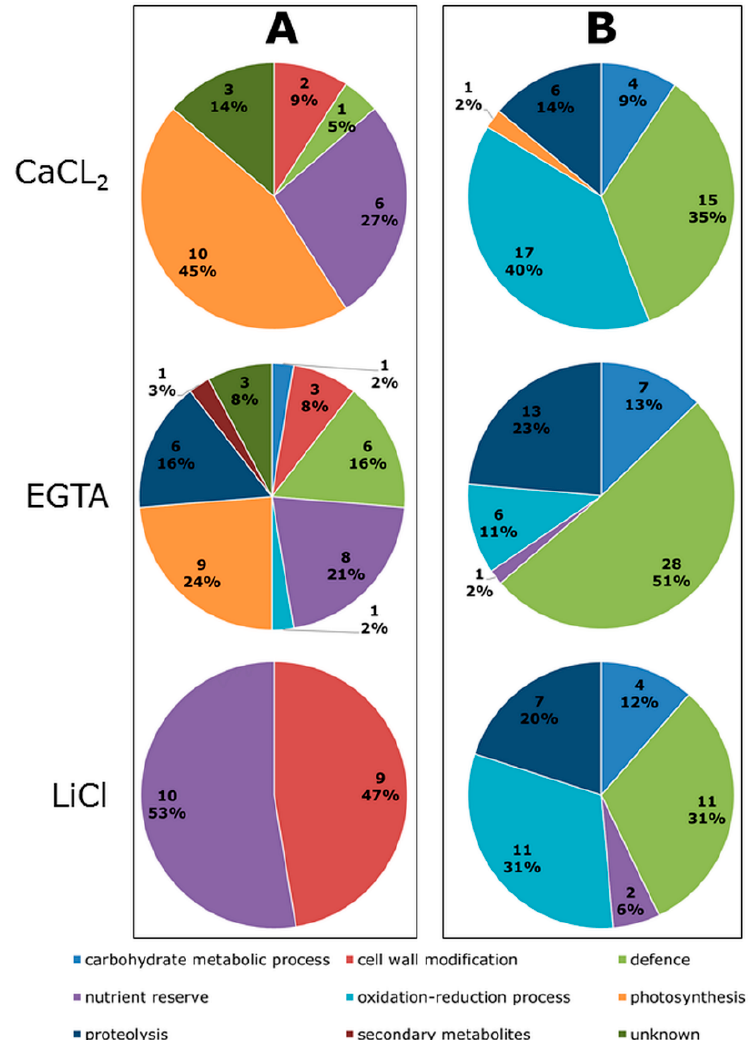
Figure 2. Functional classification of proteins present in cell wall protein-enriched fractions from M. sativa leaves after long-term exposure to Cd. M. sativa plants were exposed to Cd (10 mg/kg soil DW) for an entire season. Quantitative analysis based on four replicates were done with 2D DIGE comparing Cd-exposed samples to control samples and identified proteins clustered according to their predicted function using Blast2Go. ( A ) Functional classes of lower abundant proteins; and ( B ) functional classes of higher abundant proteins. Table 1. Summary of all identified proteins in cell wall protein-enriched fractions from M. sativa leaves, which changed significantly in abundance after long-term Cd exposure. The table is based on all identifications provided in Table S2. The targeted location was predicted with TargetP. C: chloroplast; S: secretory pathway; /: any other location.